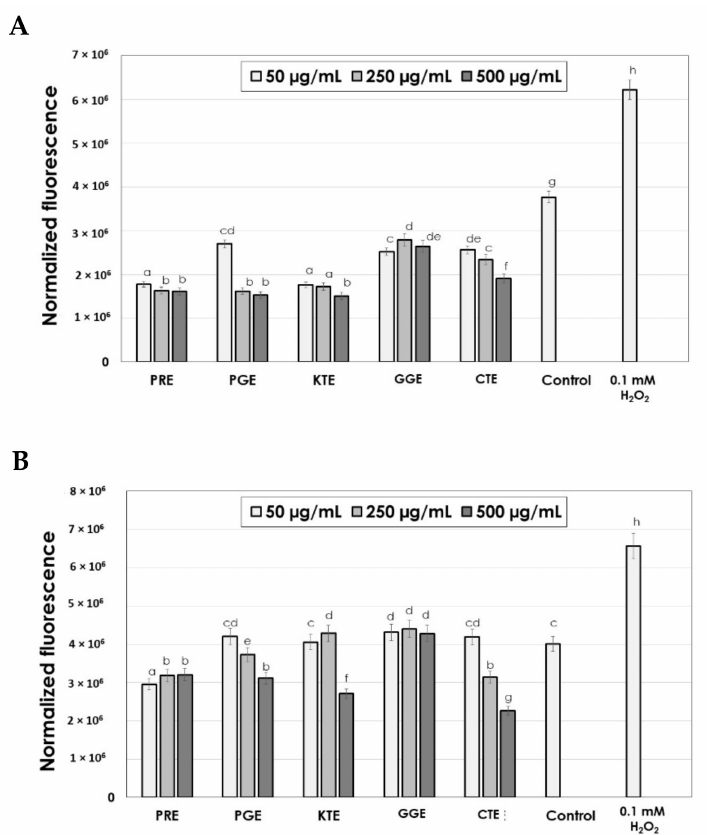
Figure 3. The effect of PRE, PGE, KTE, CTE and GGE on the 2 (cid:48) ,7 (cid:48) -dichlorofluorescein (DCF) fluo- rescence in BJ ( A ) and HaCaT cells ( B ). The data are expressed as the mean ± SD of 3 independent experiments, each of which consisted of 3 replicates per treatment